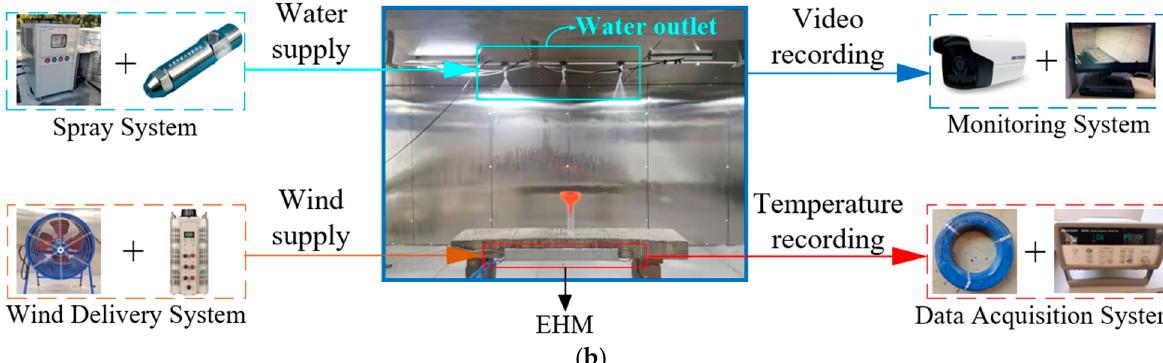
Figure 3. ( a ) The test system schematic; ( b ) the working relationships of each system. The beam model for the experiment was a rectangular beam with a 0.5 m high support placed at the bottom to support the beam. Three nozzles were arranged above the beam at a 1.7 m distance as rainfall outlets and were connected to the external chiller through a water pipe. The chiller could reduce the water temperature to 0.5~1.5 °C. The above the low temperature environment.